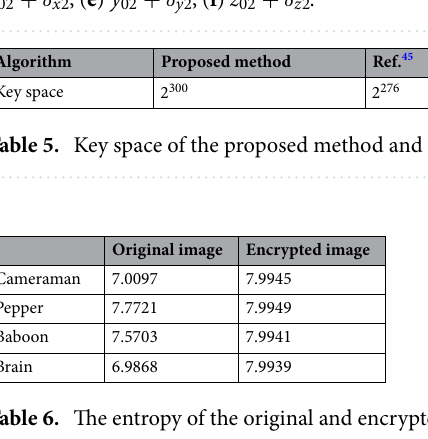
δ x 1 ; ( b ) y 01 δ z 1 ; ( d ) δ y 1 ; ( c ) z 01 + + +